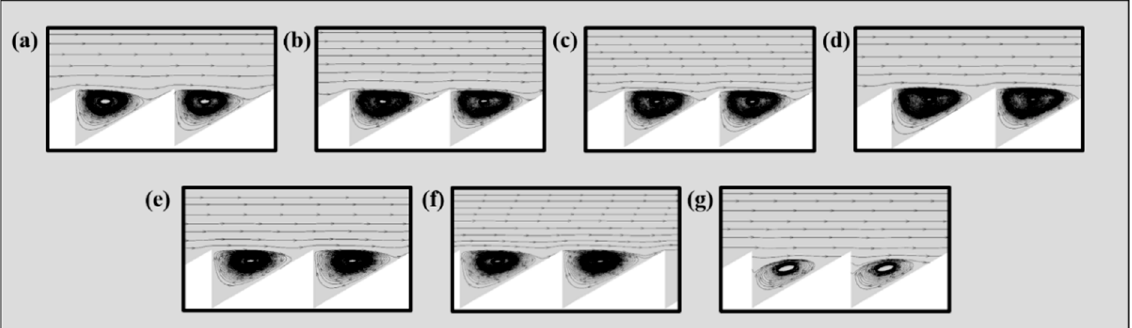
Figure 6. Velocity streamline diagram of structures under different flow velocity conditions, ( a ) 69.4 m/s, ( b ) 83.3 m/s, ( c ) 97.2 m/s, ( d ) 111.1 m/s, ( e ) 125 m/s, ( f ) 138.9 m/s, and ( g ) 250